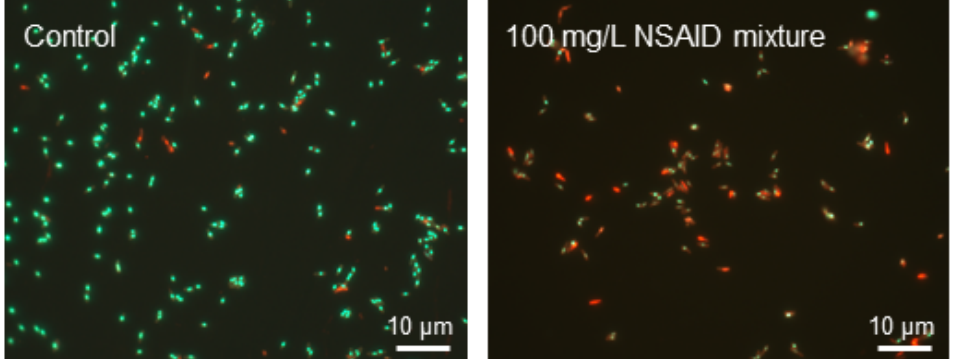
Figure 4. Fluorescent microscopy of R . cerastii IEGM 1278 cells grown for three days in the presence of 0.1 g/L glucose (control), or 0.1 g/L glucose and a mixture of NSAIDs. Cells were stained with LIVE/DEAD Bacterial Viability kit (live/dead = green/red, respectively).